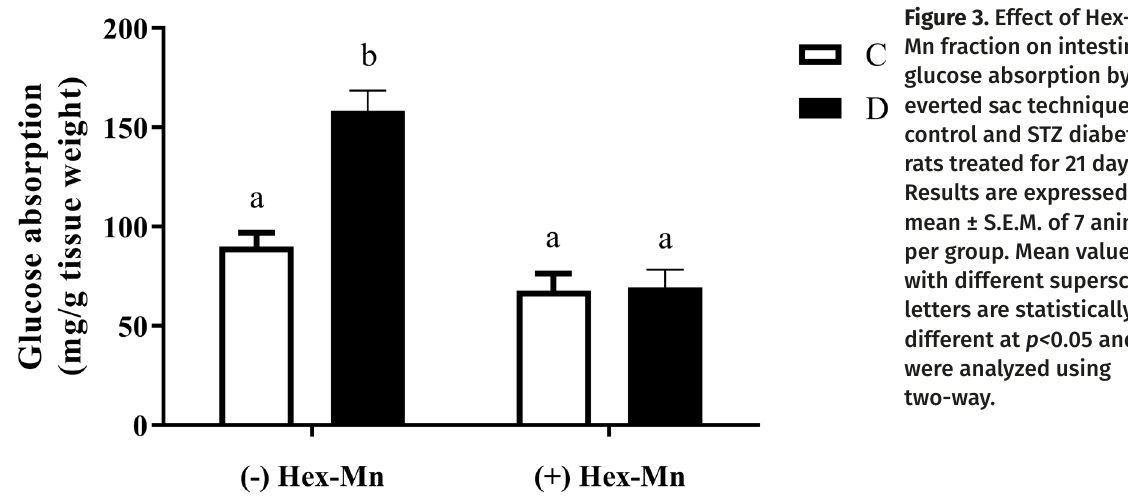
Figure 3. Effect of Hex- Mn fraction on intestinal glucose absorption by everted sac technique in control and STZ diabetic rats treated for 21 days. Results are expressed as mean ± S.E.M. of 7 animals per group. Mean values with different superscript letters are statistically different at p< 0.05 and were analyzed using